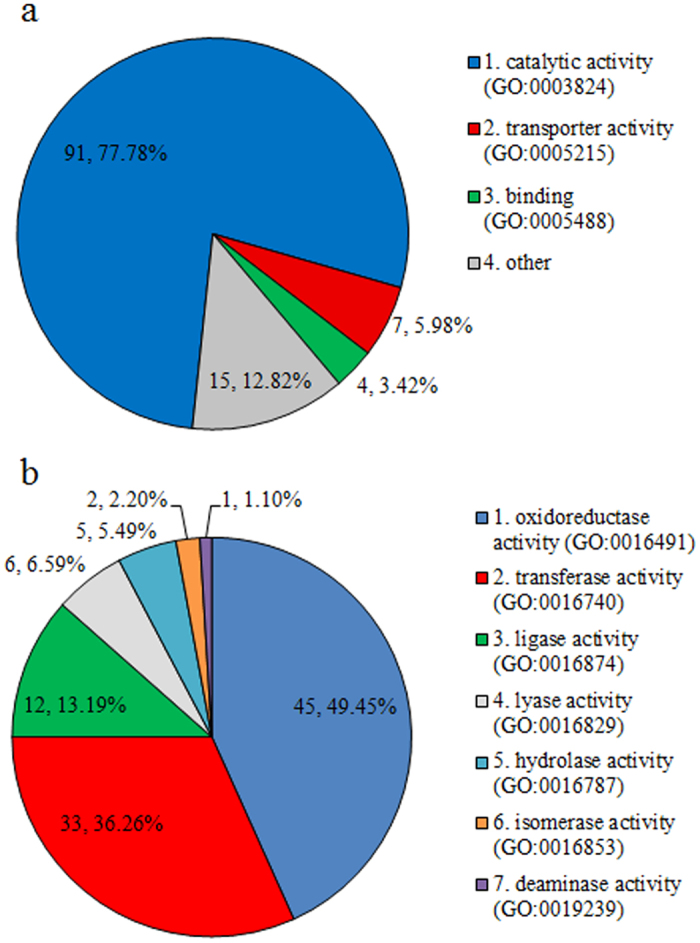
Pie chart of gene functions in 7 pathways.(a) Pie chart of PANTHER GO-slim molecular function of 117 genes. (b) Pie chart of 91 genes who have the function of catalytic activity (some gene may have more than one function, so the sum of genes is not 91).